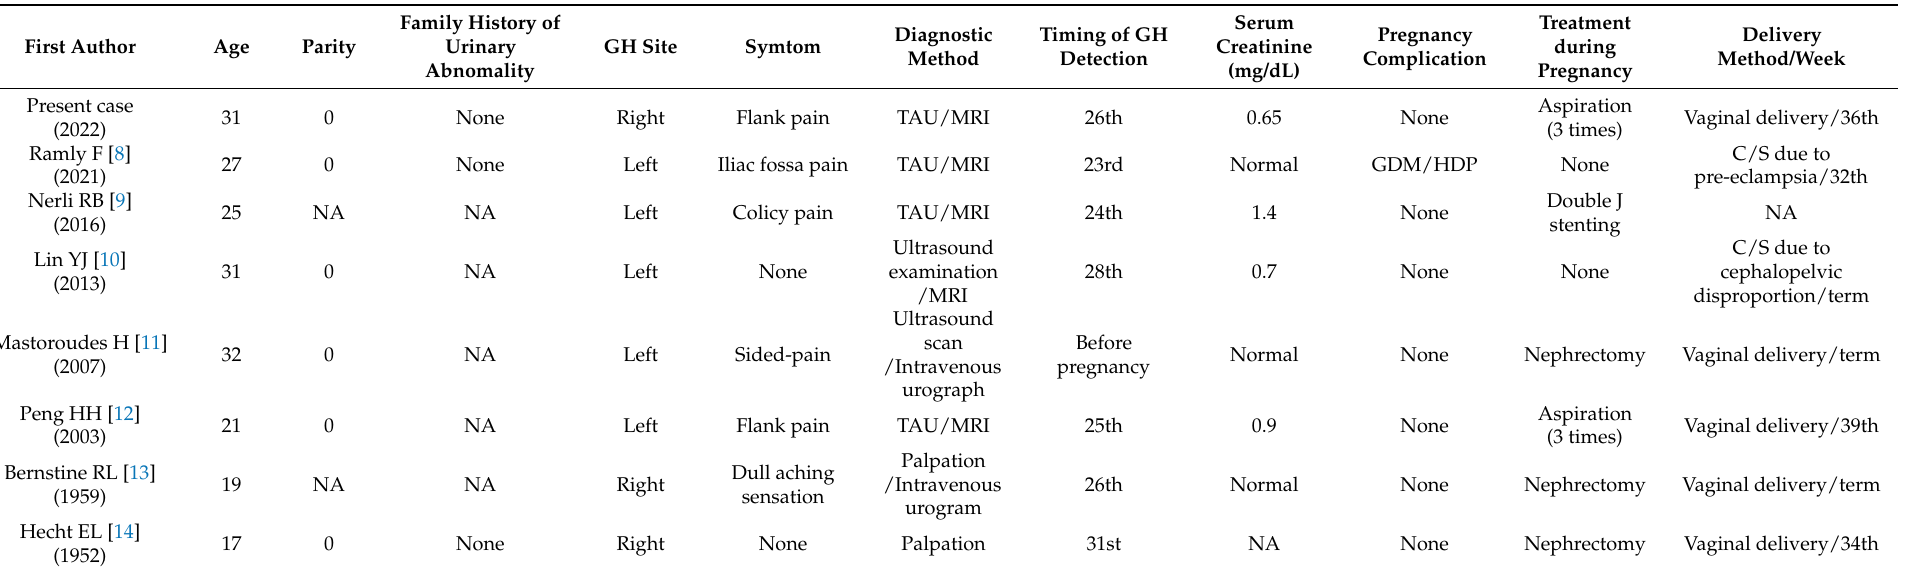
Table 1. Literature review of pregnancy with GH due to